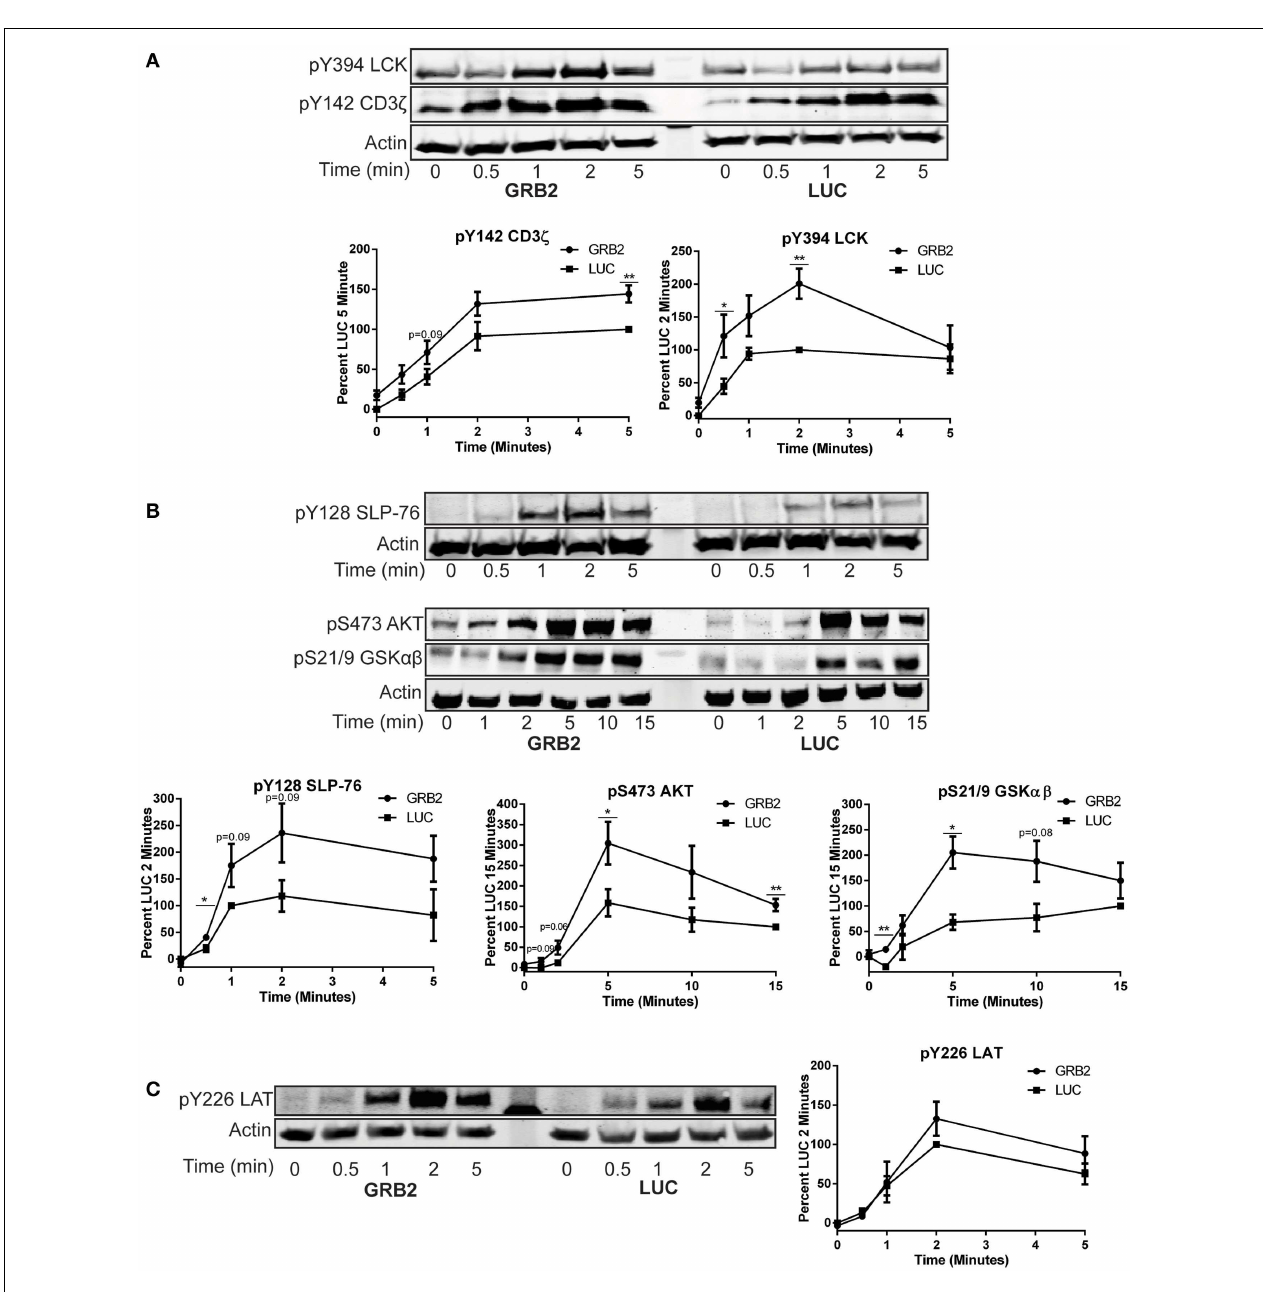
CD3 ζ chain n = 5. (B) pY128 SLP-76 n = 6, pSer473 AKT n = 7, pSer21/9 GSK αβ n = 3. (C) pY226 LAT n = 5.The levels of phosphorylation were normalized to actin expression and graphed as mean percentage phosphorylation of LUC ± SEM for each time